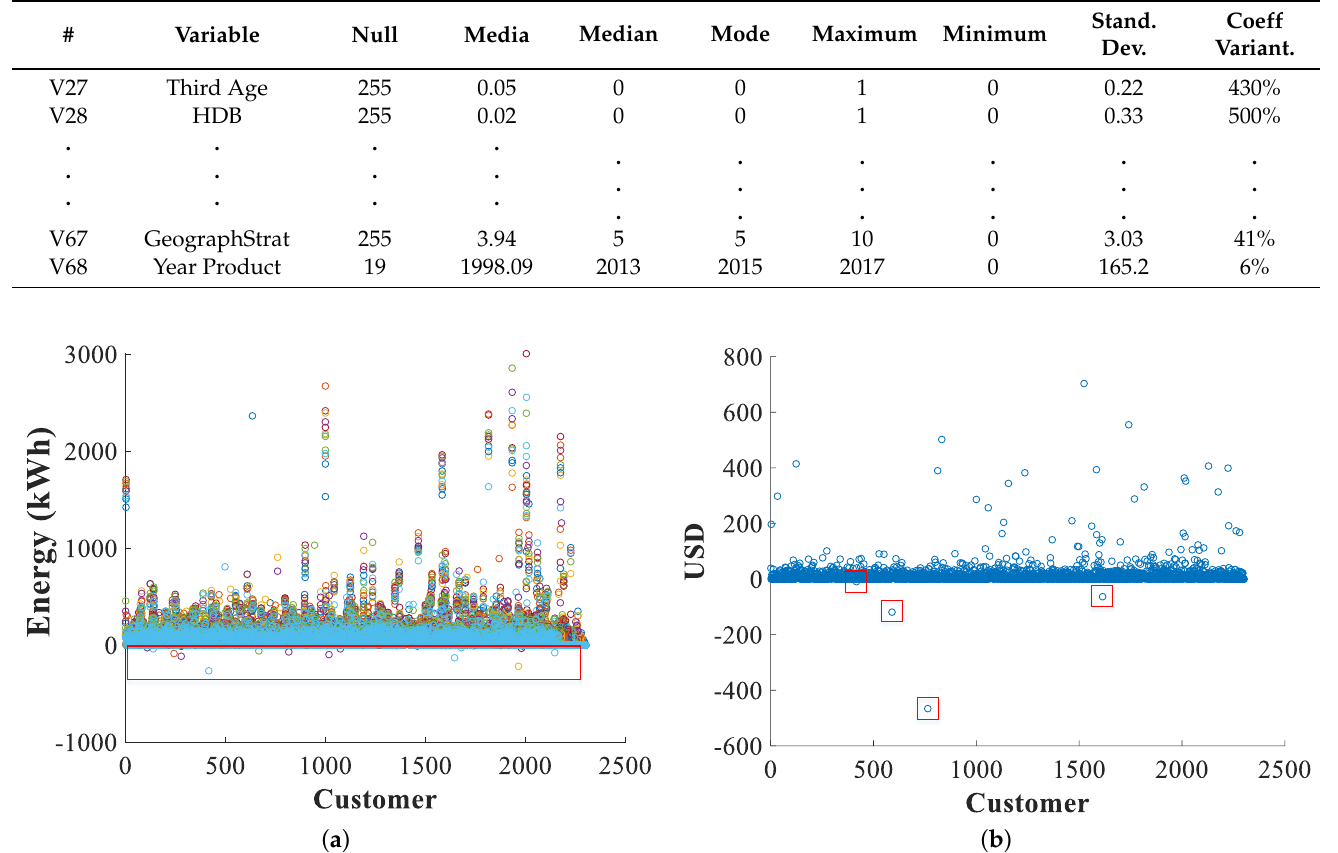
Table 5. Data analysis using descriptive statistics.